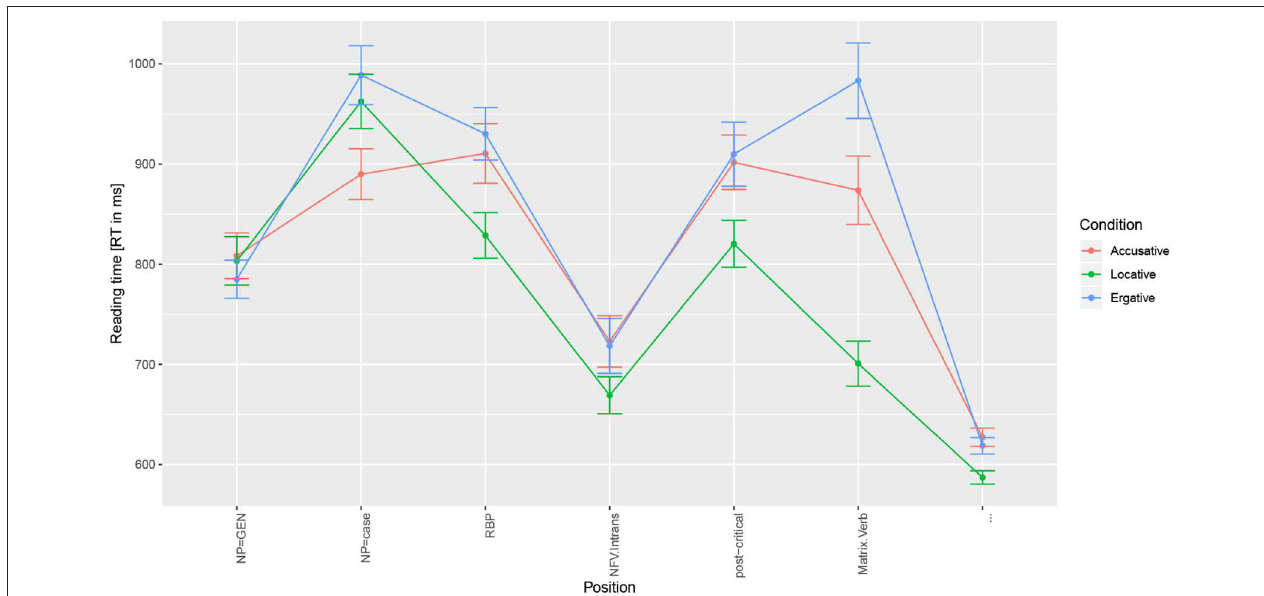
FIGURE 2 | Reading time for all the regions in the target sentence for the three conditions in Experiment 3. “NFV.Intrans” is the critical region; “post-critical” is the post-critical